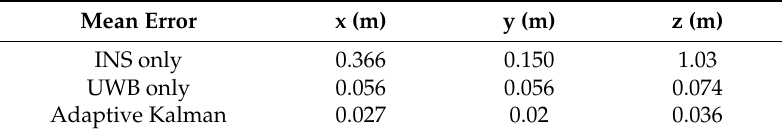
Table 2. Mean errors of different methods.